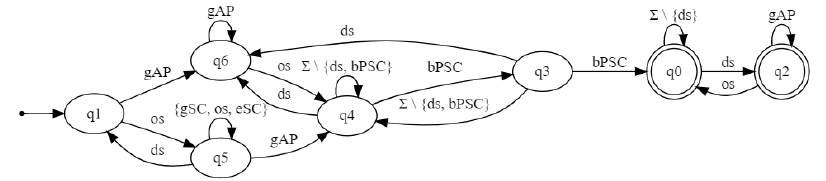
Figure 9. E-commerce system: Automaton for Ψ 2 ( C )